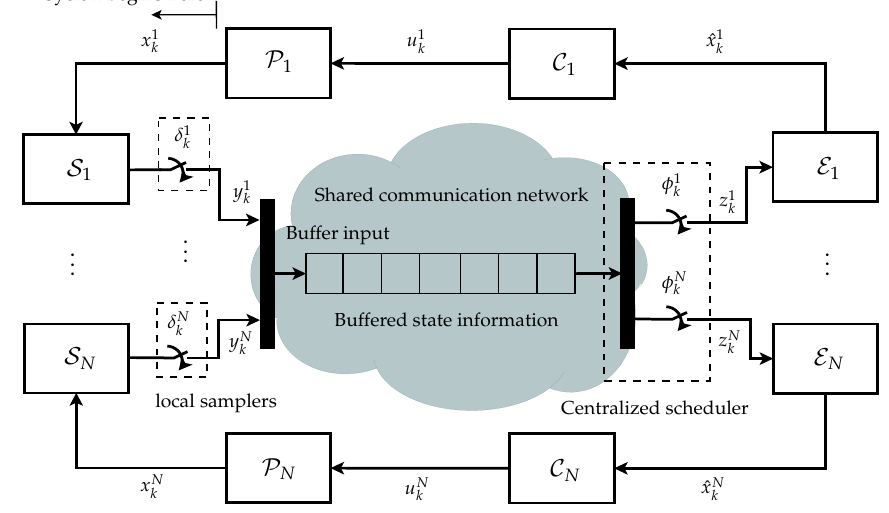
Figure 1. Multi-loop NCS with a shared communication network equipped with a data storage buffer.